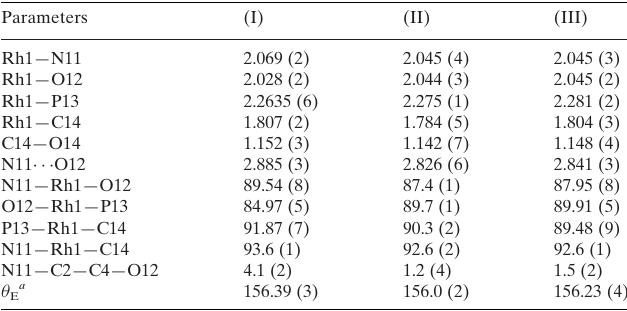
Comparative geometrical parameters for similar [Rh( N , O -bid)(CO)- (PPh 3 )] complexes (A˚ , (cid:2)